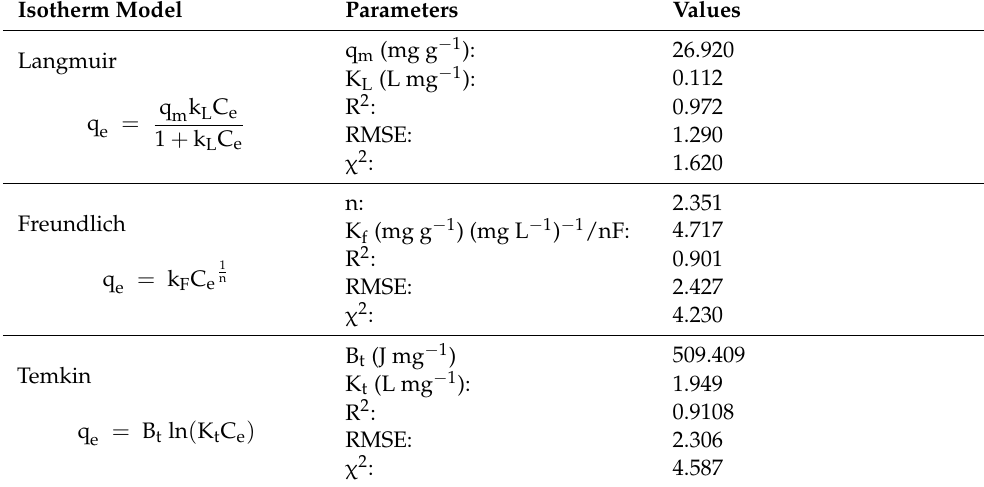
Table 2. Adsorption isotherm parameters for Br − onto